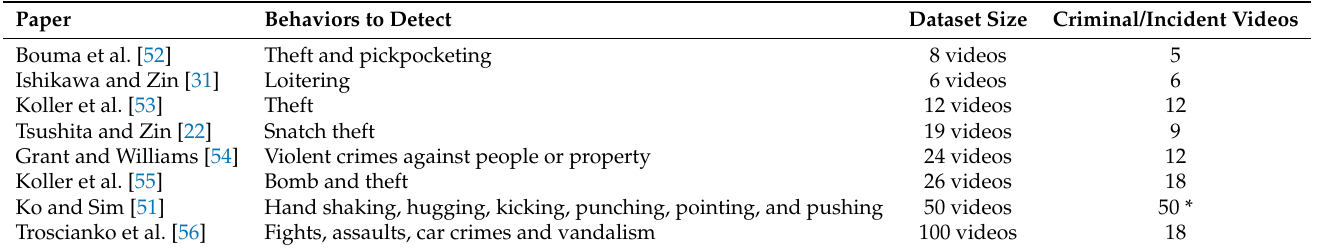
Table 1. Some relevant examples of works related to behavior detection, their dataset size, and the number of criminal videos considered. * Ko and Sim’s work [51] presents many incident videos due to their behaviors as abnormal; however, they do not represent a crime